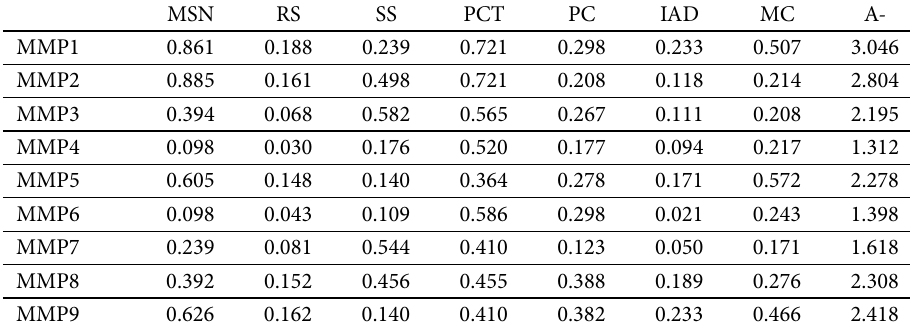
Table 13. The distance measurements from FNIS